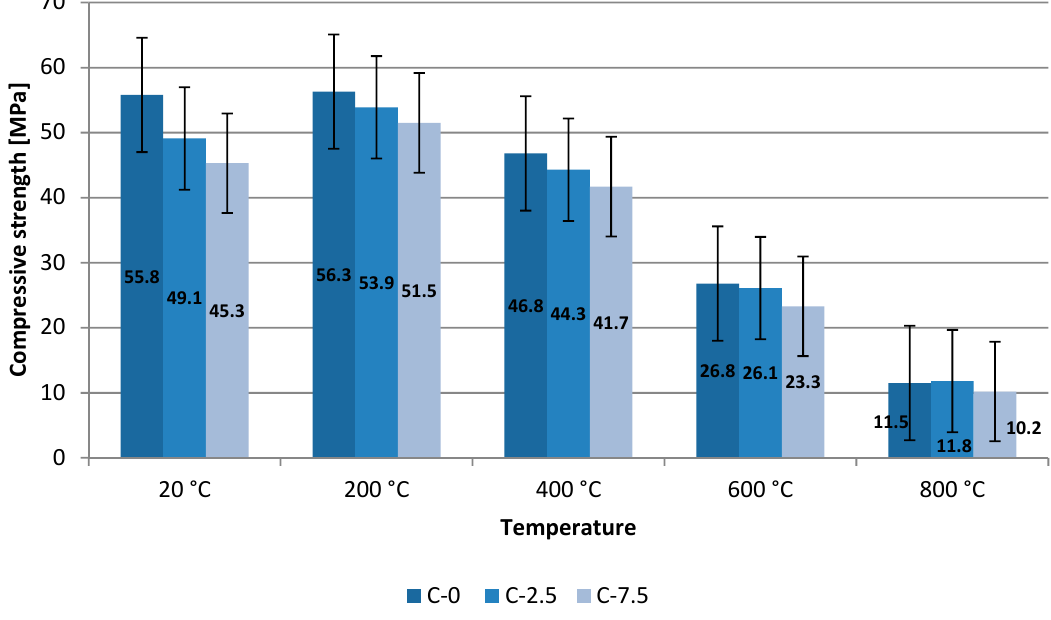
Figure 7. Compressive strength of concrete with heated composite after 180 days — 10 cm cubes.